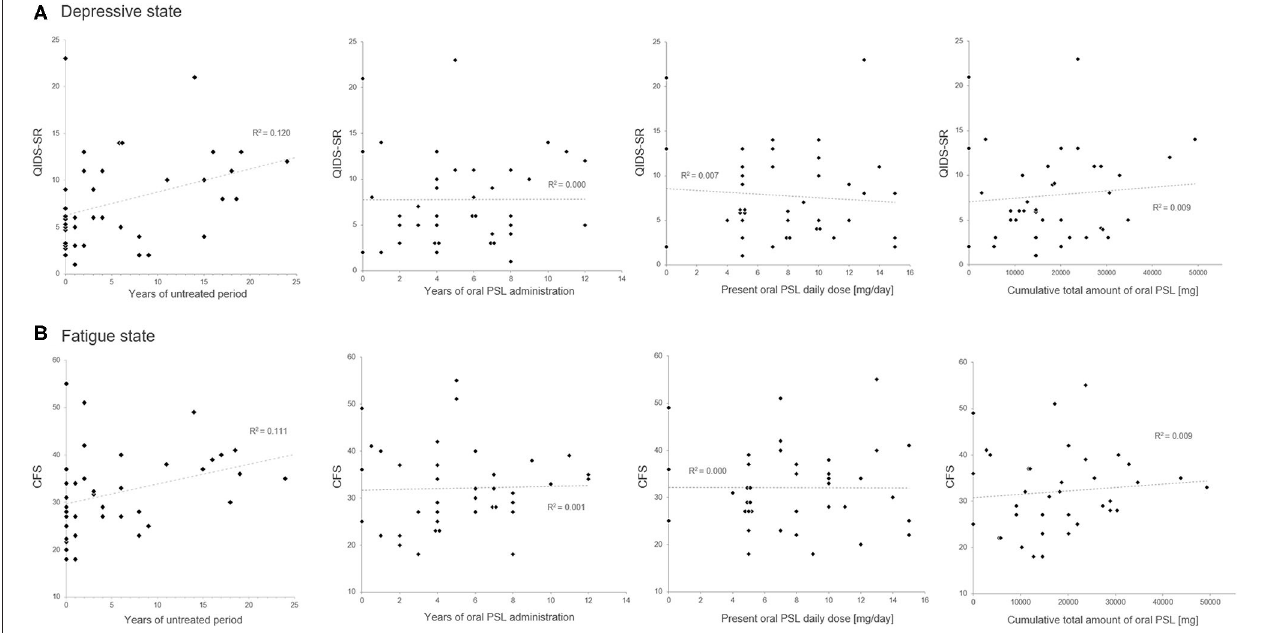
FIGURE 1 | Scatter plots of the oral prednisolone-related therapeutic variables and the insidious symptoms. The duration of the untreated period shows a positive correlation with the present scores in QIDS-SR (A) and CFS (B) . Meanwhile, none of the present oral prednisolone dosage, duration of prednisolone administration, or cumulative total amount of oral prednisolone shows a significant correlation with the present depressive state or fatigue level. CFS, Chalder Fatigue Scale; PSL, prednisolone; QIDS-SR, self-reported Quick Inventory of Depressive Symptomatology.